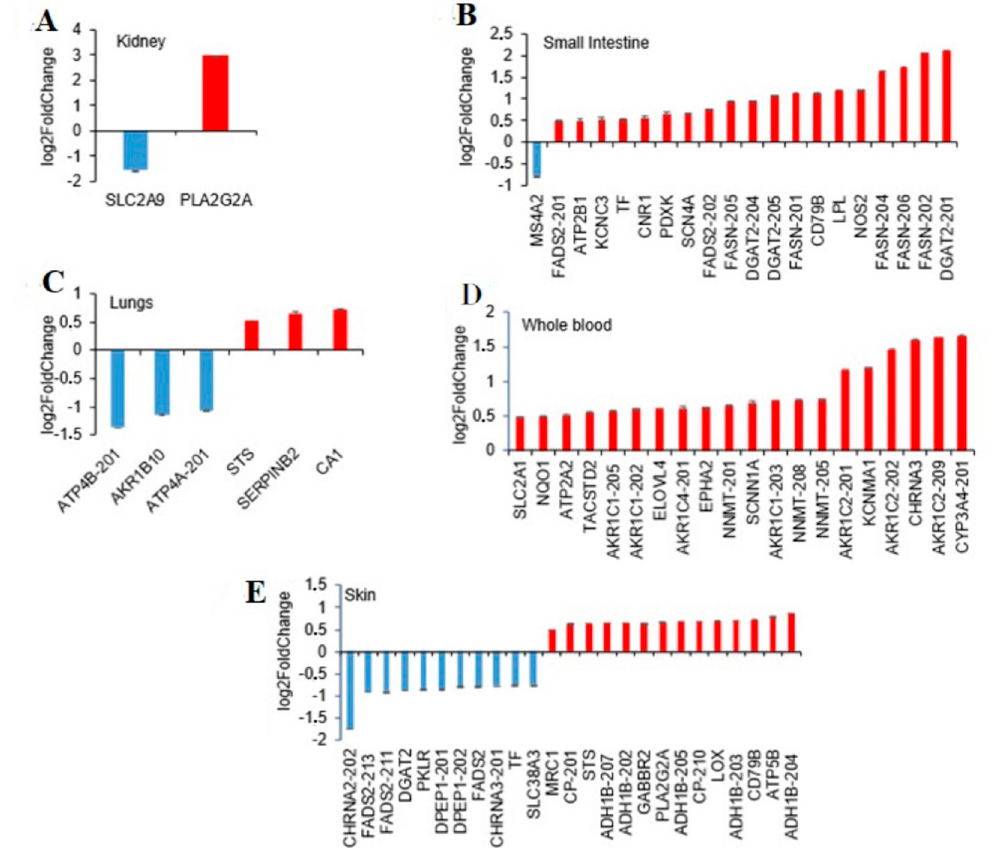
Figure 4. Sex-differential gene expression of pharmacogenes in relevant tissue for drug metabolism. Transcripts showing differential abundance, which are at least 40% of up- or downregulated in females compared to males, were plotted for the most relevant tissue implicated in drug metabolism. ( A ) Kidney. ( B ) Small intestine, terminal ileum. ( C ) Lungs. ( D ) Whole blood. ( E ) Skin, not exposed sun.